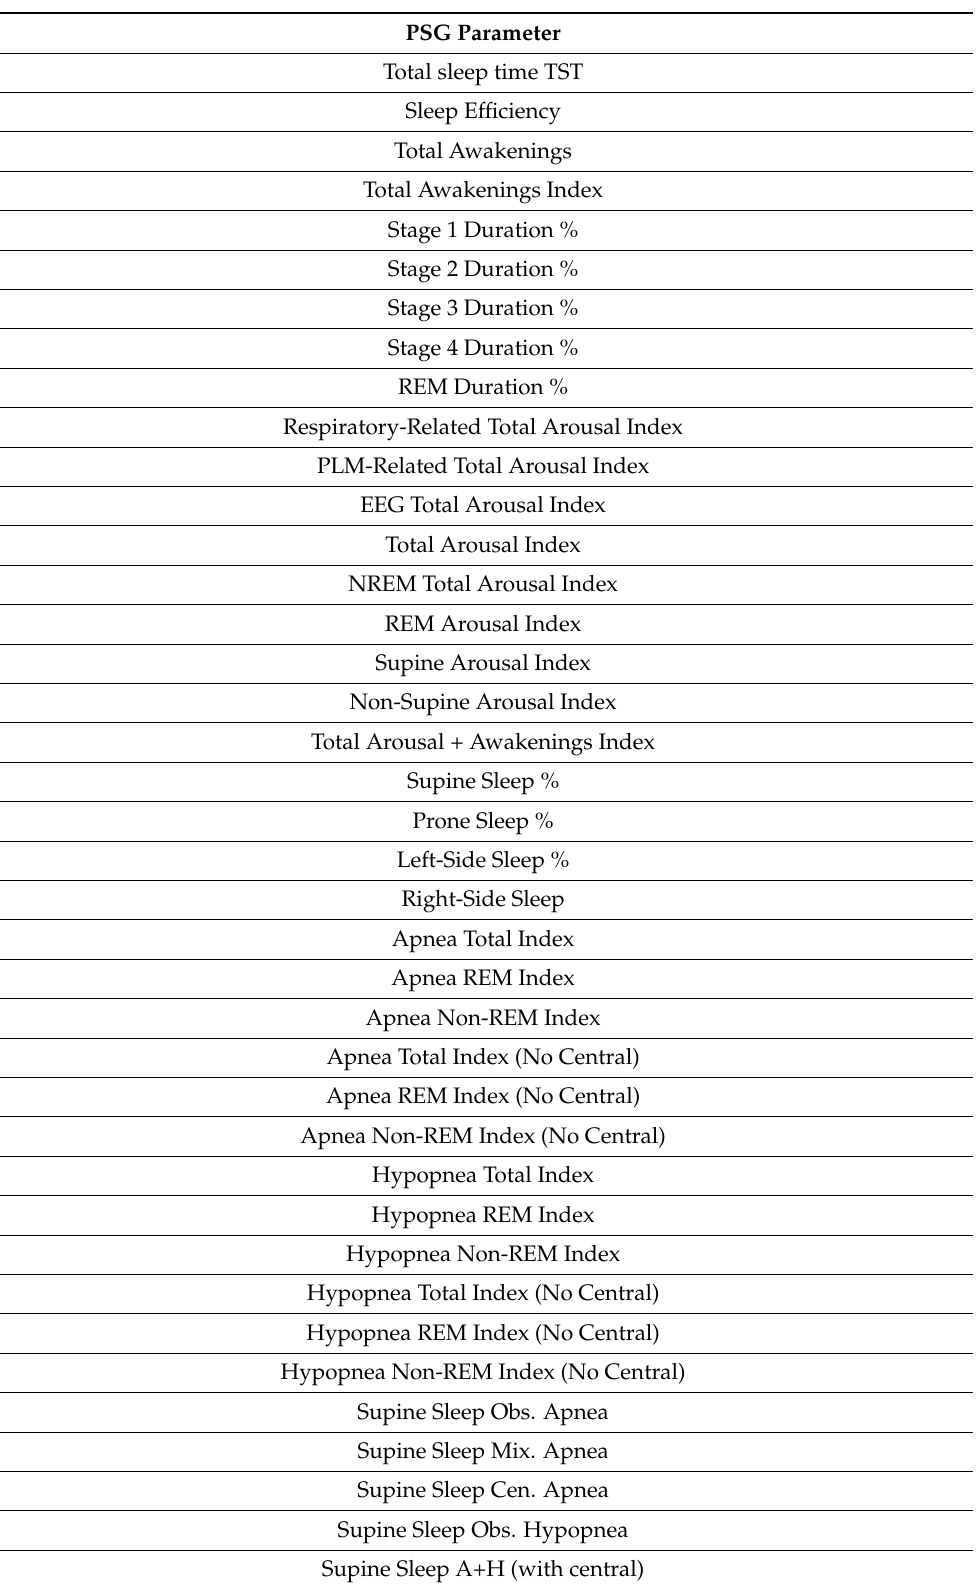
Table A1. Shows the extracted PSG parameters from the PSG